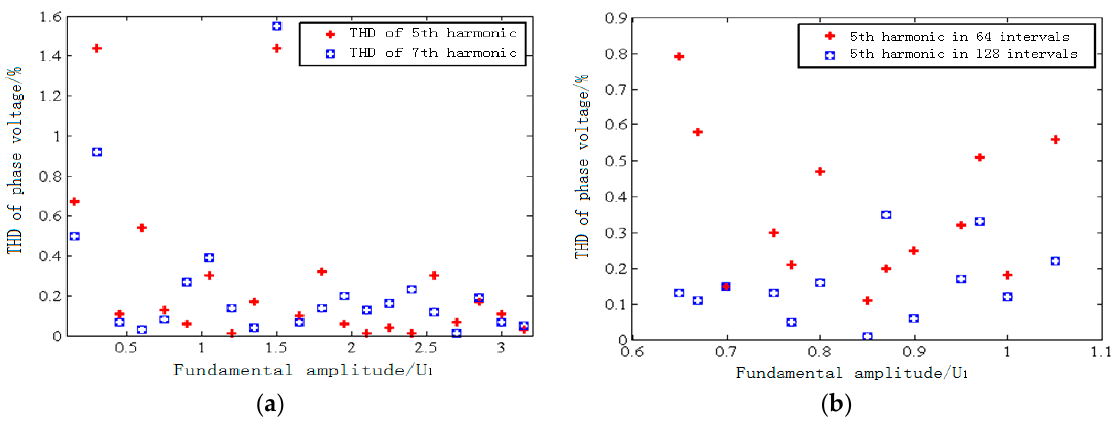
Figure 8. Harmonic percentage with fundamental amplitude in the phase voltage. ( a ) Percentage of harmonic with fundamental amplitude for 5th, 7th harmonic in phase voltage. ( b ) Percentage of harmonic with fundamental amplitude for 5th harmonic based on C waveband.